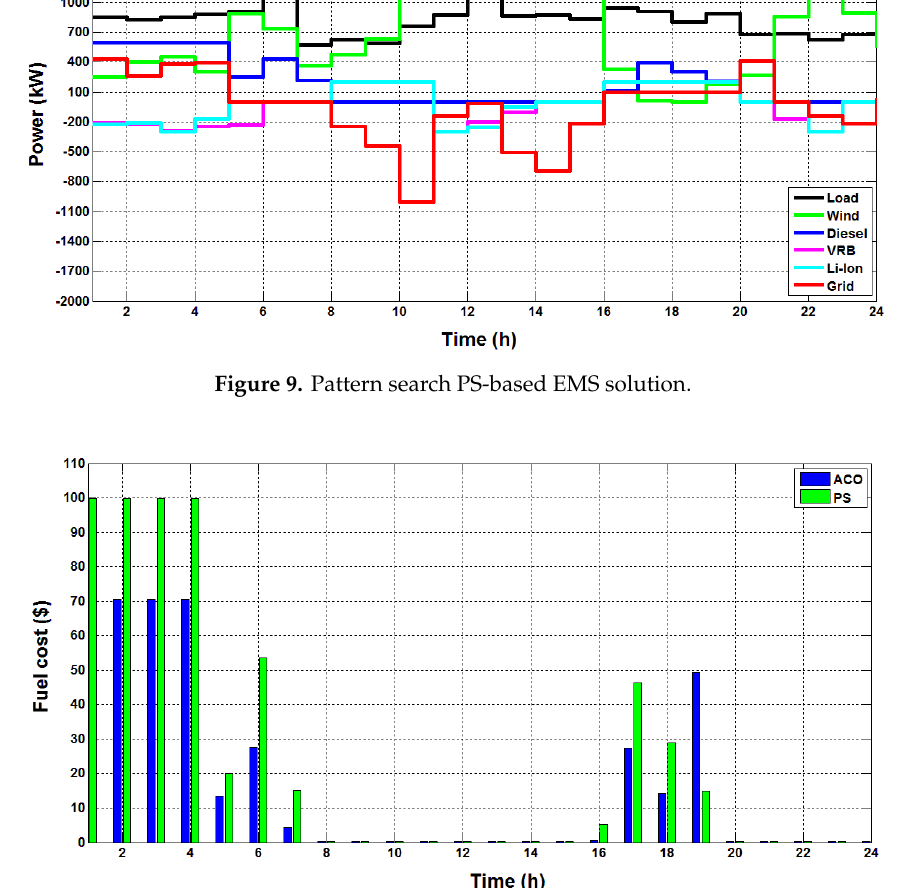
Figure 10. Power production fuel cost comparison.